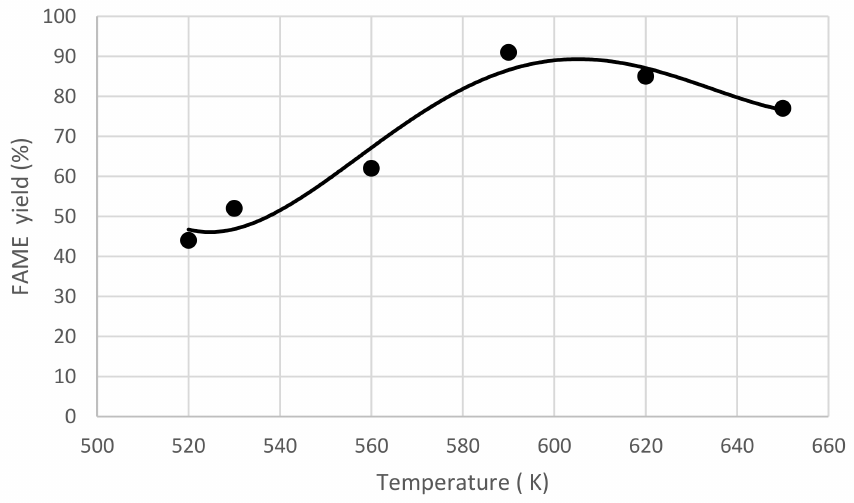
Figure 6. FAME yield (%) at variable temperature (P = 351 bar, Time = 15 min and Molar ratio =